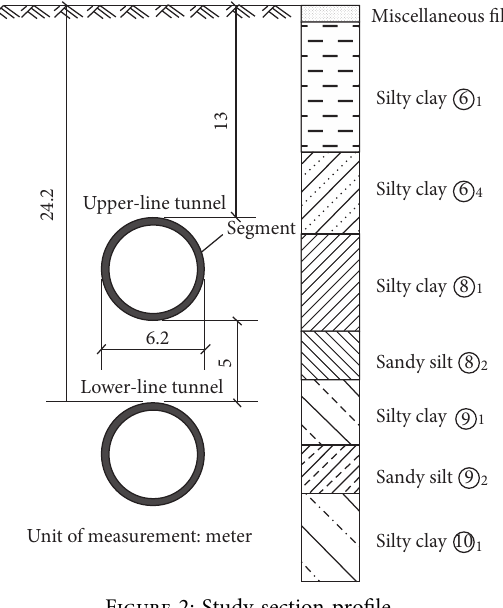
Figure 2: Study section profile.